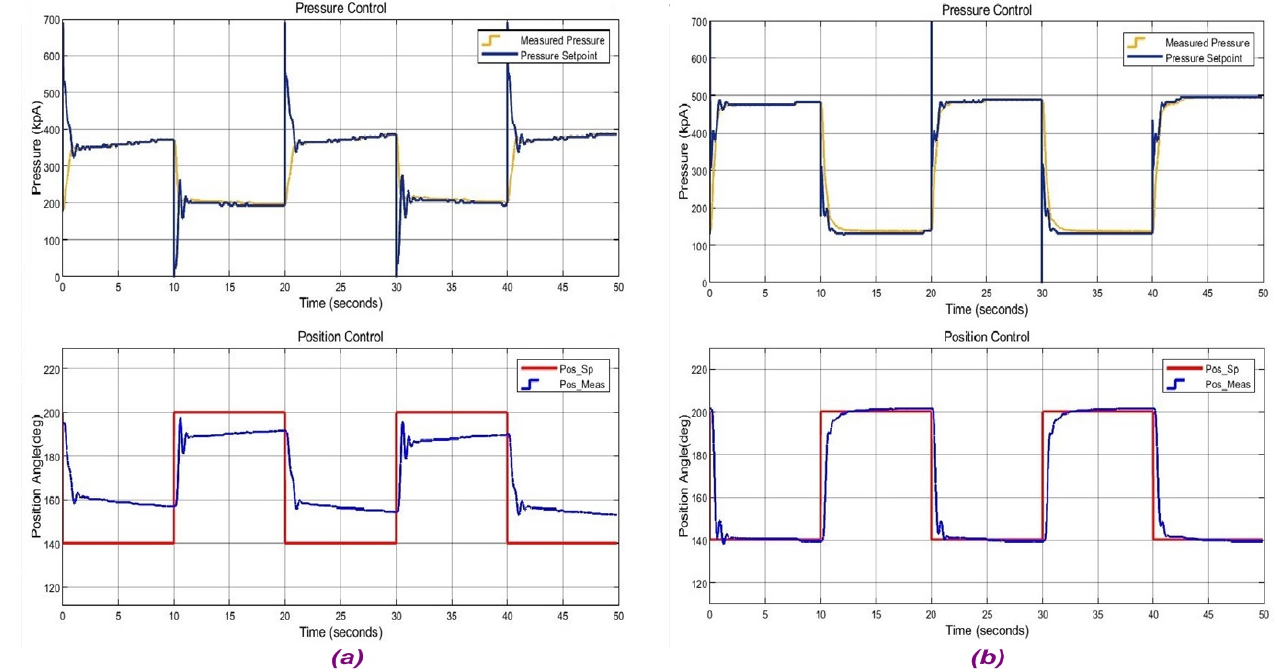
Figure 20. Performance comparison results for step reference position tracking: ( a ) PID-only opera- tion and ( b ) NARX active operation. and ( b ) NARX active